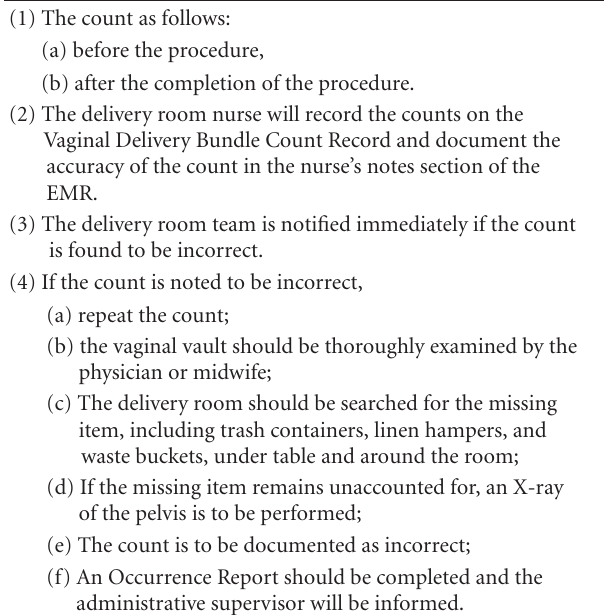
Table 1: Institutional policy for vaginal delivery sponge count.